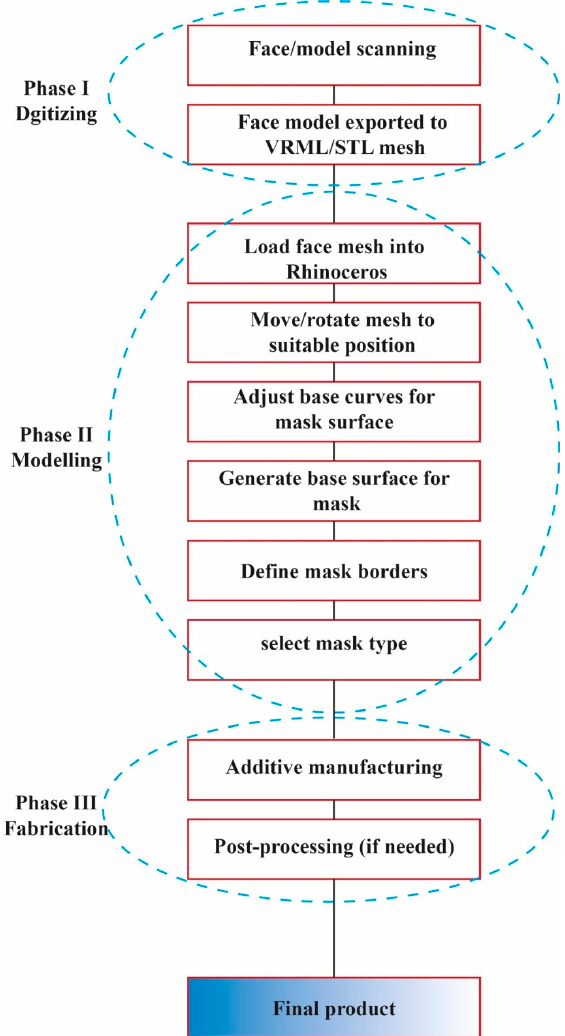
Figure 8. Methodology in additive manufacturing of a face mask [52].